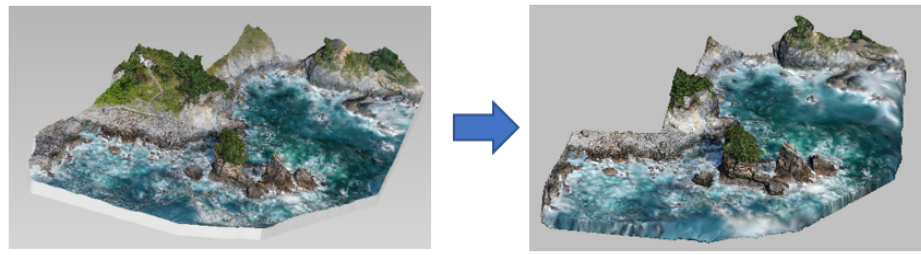
Figure 11. Noise reduction and pruning.